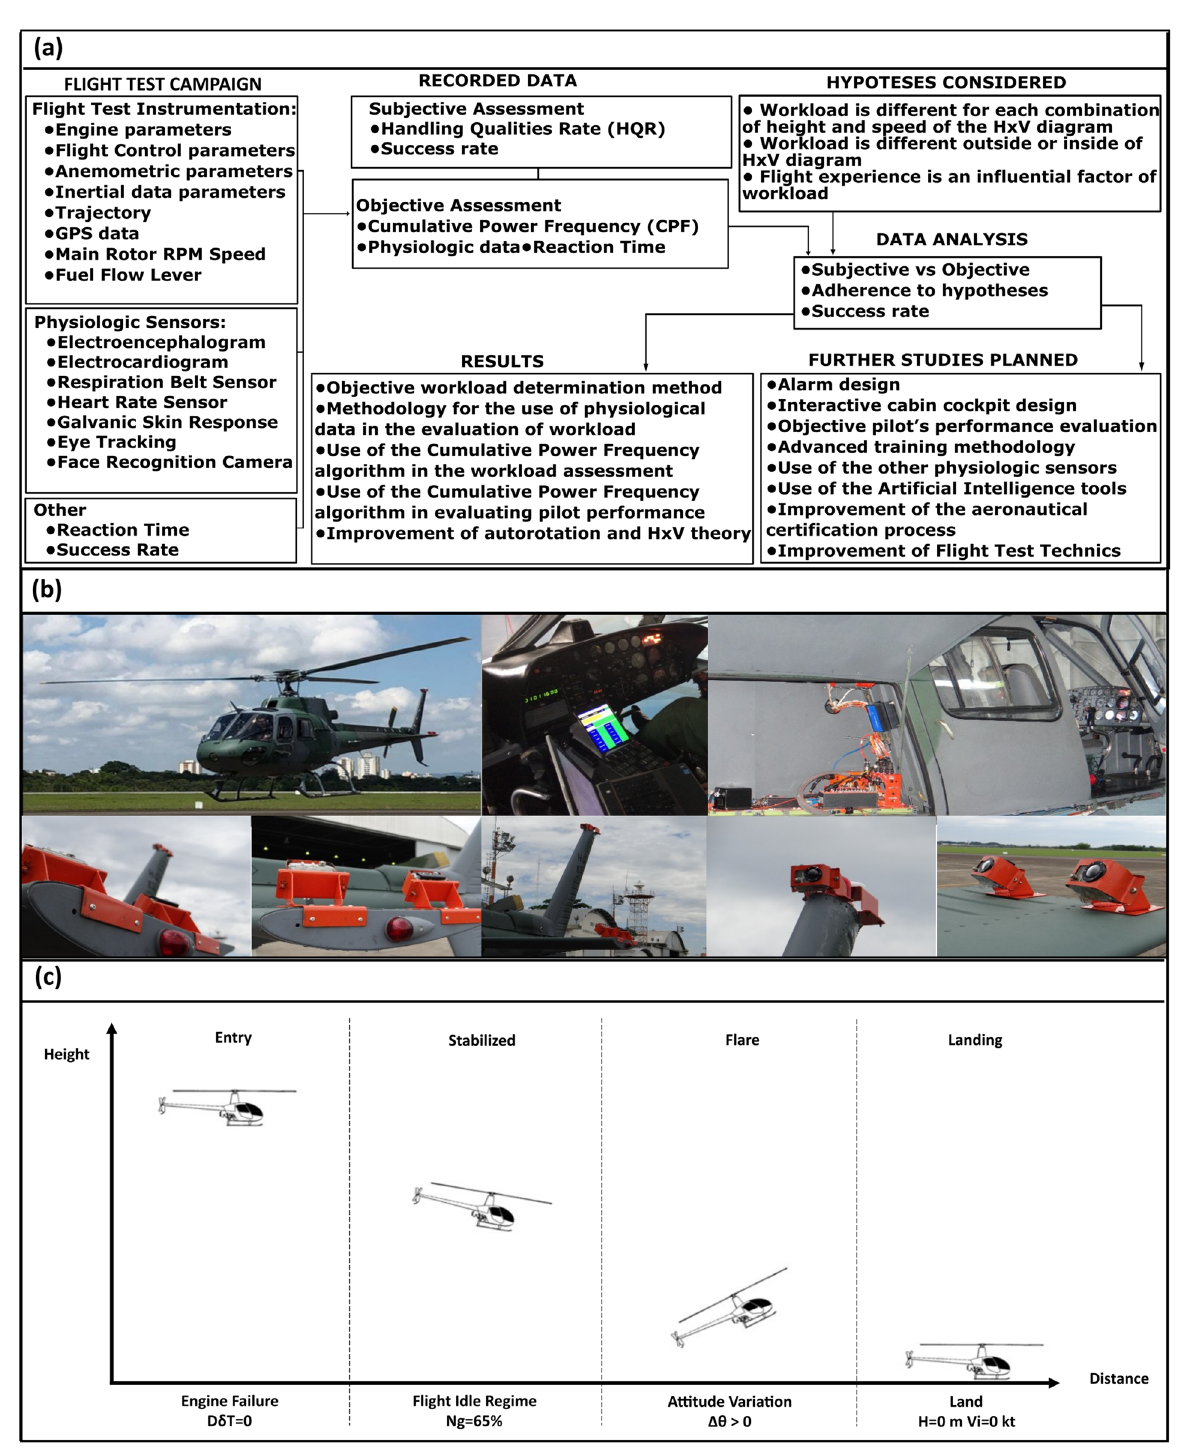
Figure 1. (a) Flowchart of the experiment and methodology proposed. (b) AS-350 helicopter and its Flight Test Instrumentation (FTI). (c) Stages of autorotation. Fuel lever control position (DδT). Turbine Gas generator Speed (Ng). Attitude variation (Δθ). Height (H). Airspeed